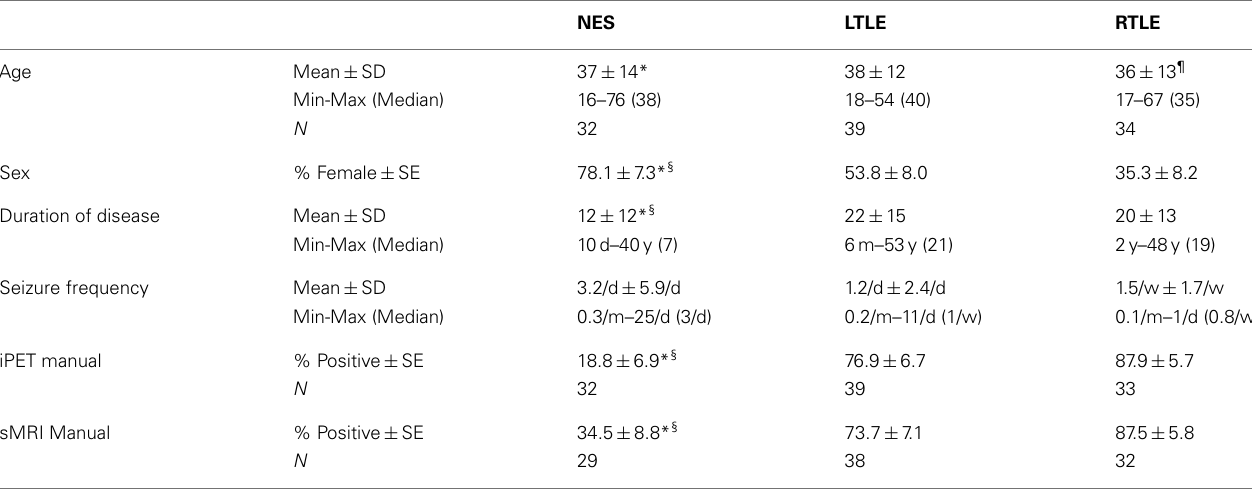
Table 1 | Clinical information and results of manual